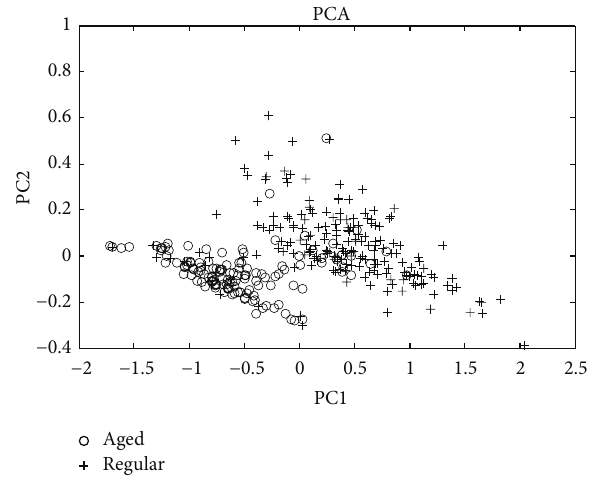
Figure 2: PCA plot of the 197 regular and 133 aged shiitake